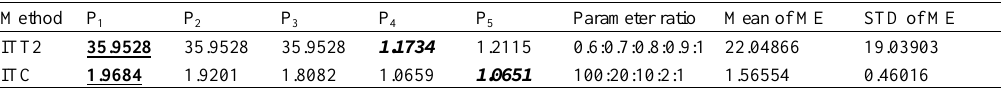
Table 1. Result of circle in experiment